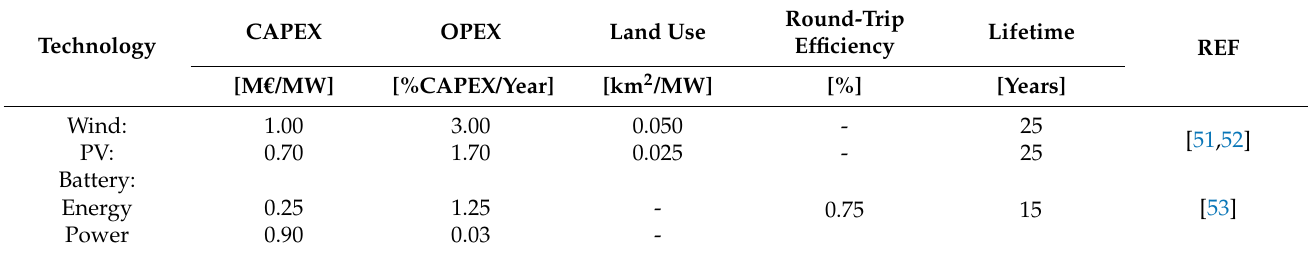
Table 3. Summary of the inputs regarding the technology costs and performance used in the